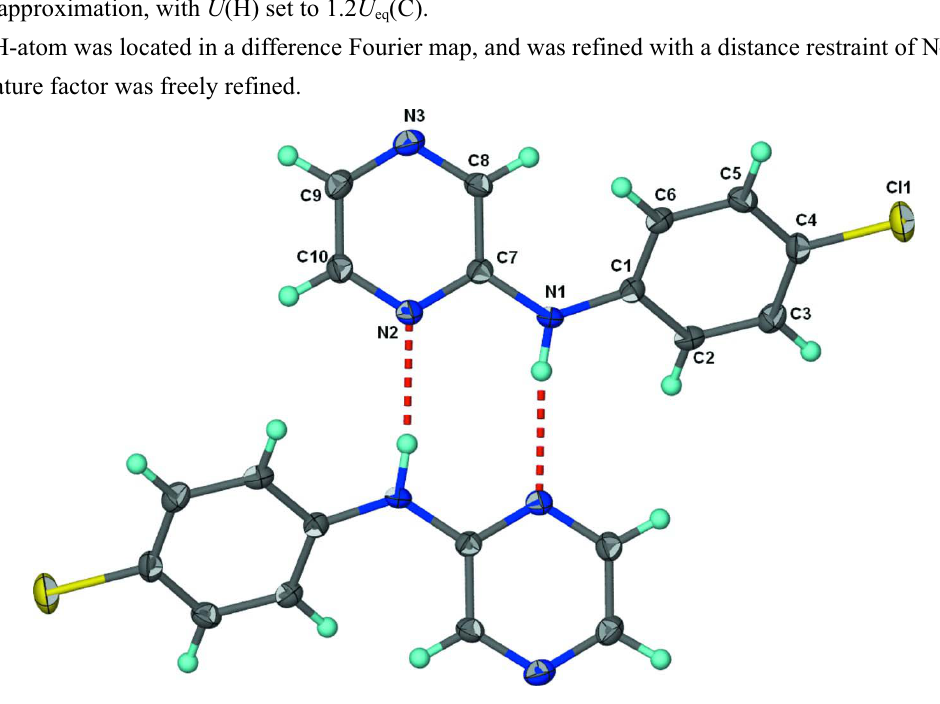
H ClN at the 70% probability level. 10 8 3